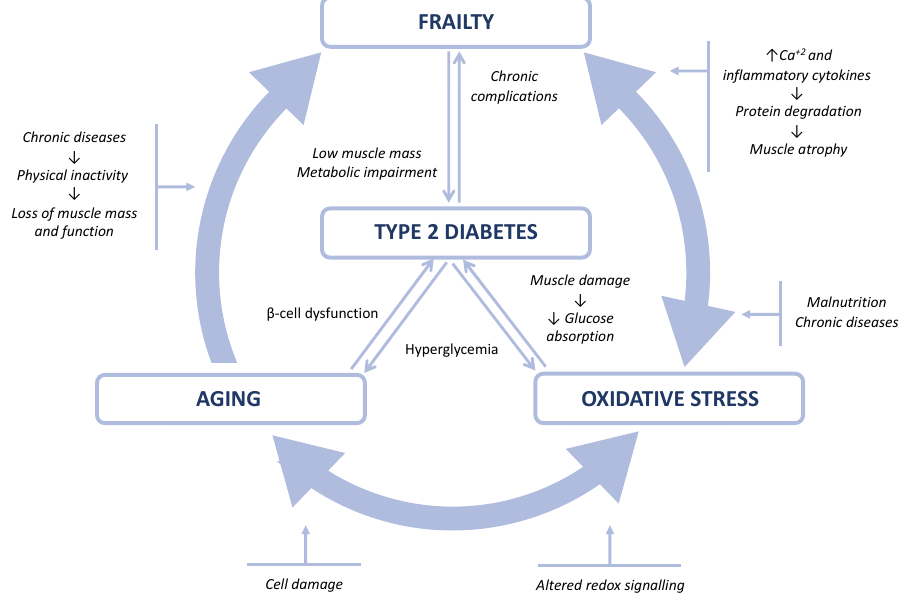
Figure 1. Relation between frailty, oxidative stress, aging, and type 2 diabetes mellitus.